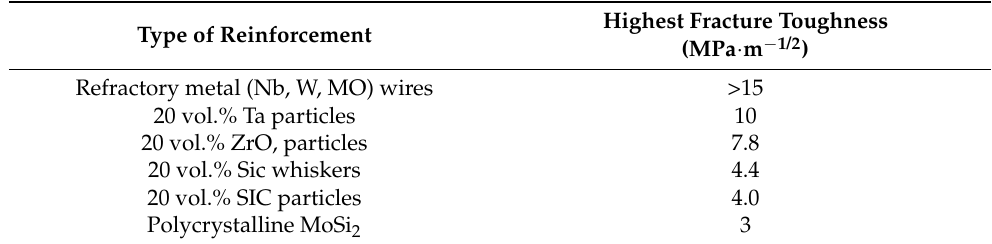
Table 6. Room-temperature fracture toughness of MoSi 2 -based composites [71].